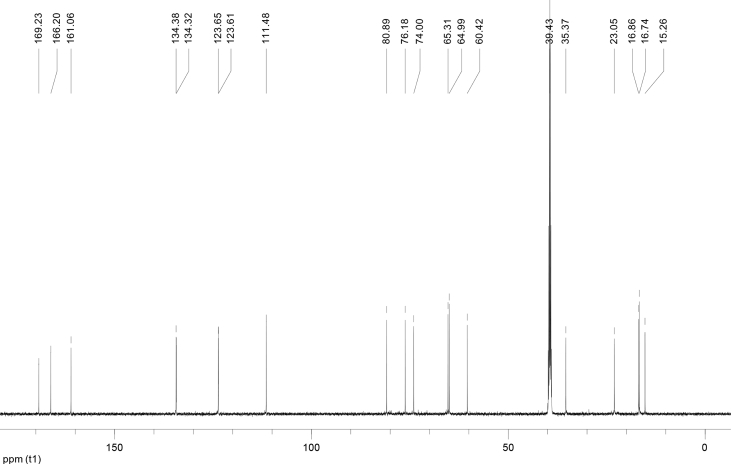
13C NMR (DMSO-d6) spectrum of compound 5.